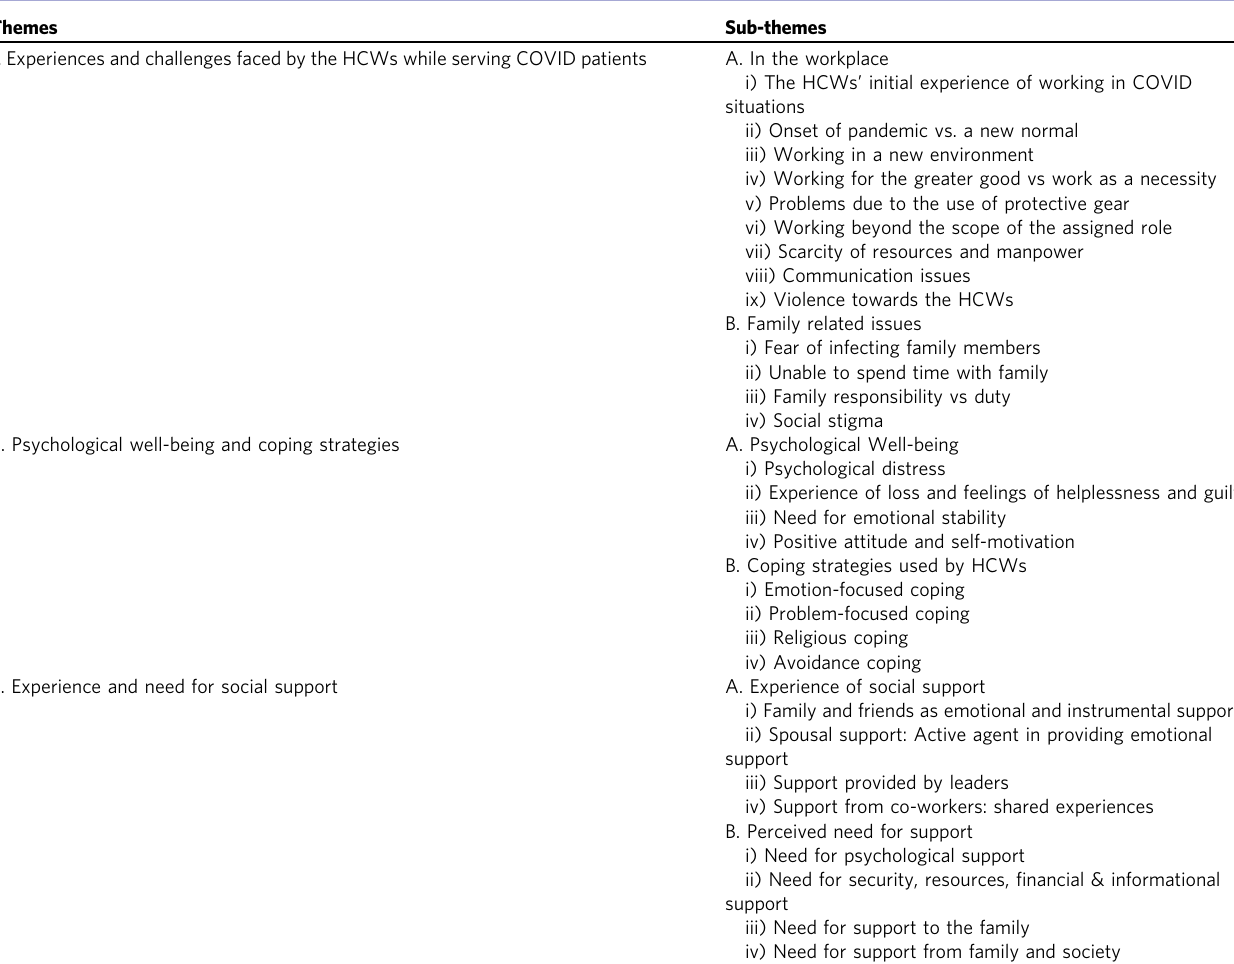
Table 3 Emergent themes and